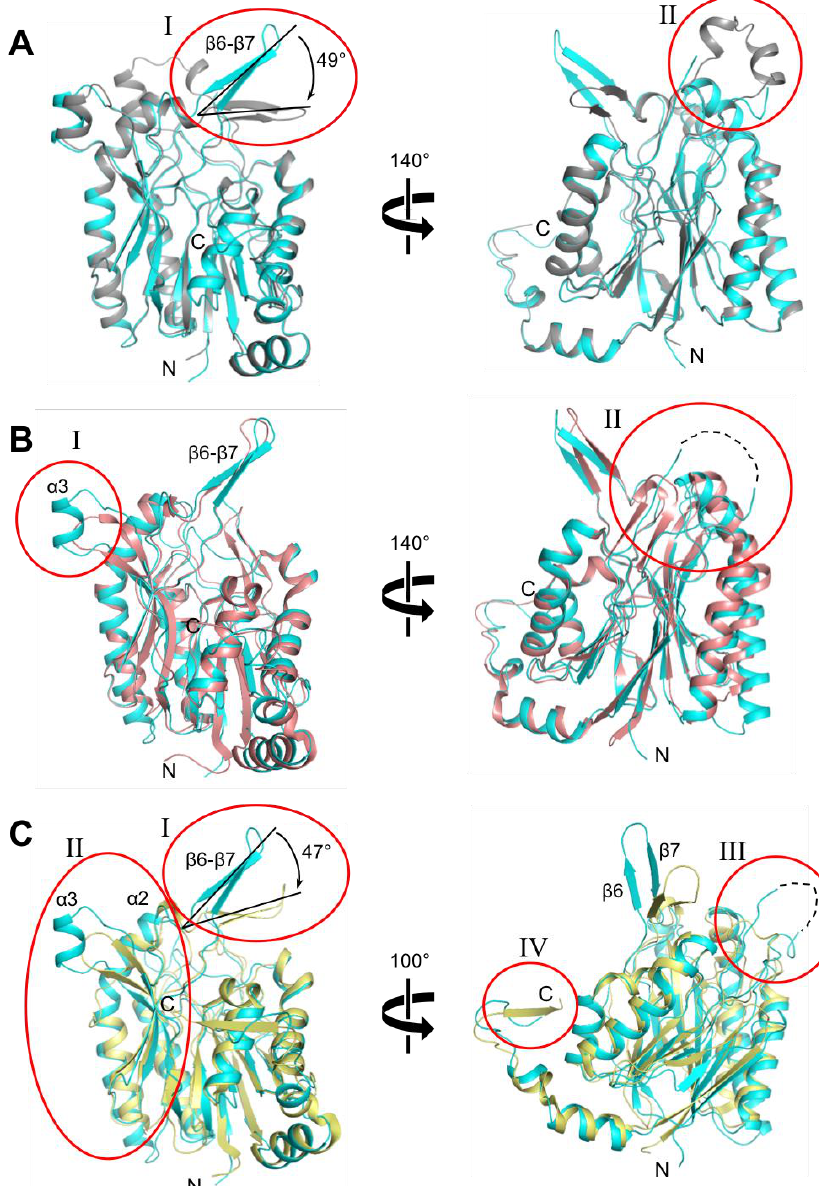
Figure 5. Structural comparison of Nit2 homologs. ( A ) The overall structures of KlNit2 and ScNit2 (PDB code, 4H5U) are depicted in the left panel in cyan and gray, respectively. The right panel shows the view of a 140 ◦ rotation along the Y -axis from the orientation compared to the left panel. The two different structural regions (I, II) are indicated by red circles with annotations. ( B ) The left panel shows the overall structures of KlNit2 and NitFhit from Caenorhabditis elegans (cNitFhit; PDB code, 1EMS) in cyan and salmon, respectively. The right panel highlights the view of a 140 ◦ rotation along the Y -axis compared to the orientation shown in the left panel. The two different structural regions (I, II) are indicated by red circles with annotations. ( C ) The overall structures of KlNit2 and mouse Nit2 (MmNit2, PDB code, 2W1V) are depicted in the left panel in cyan and yellow, respectively. The right panel shows the view of a 100 ◦ rotation along the Y -axis compared to the orientation shown in the left panel. The four different structural regions (I–IV) are indicated by red circles with annotations. The figures were generated using the graphics program PyMOL (Schrödinger Inc., New York, NY,